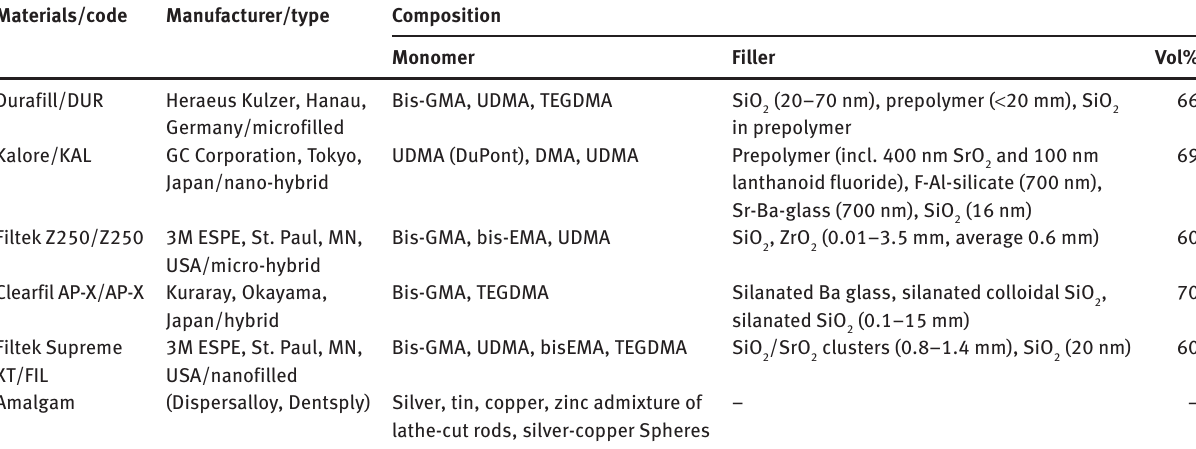
Table 1: Tested restorative composite materials.